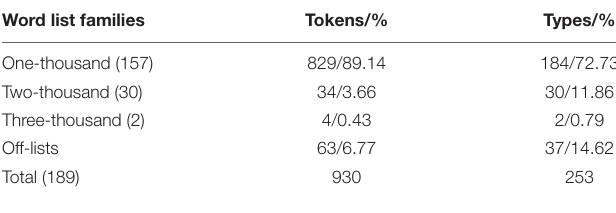
TABLE 2 | Lexical frequency profile: “Piano